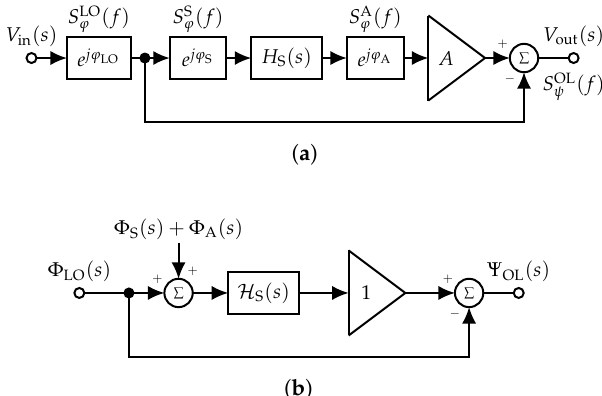
Figure 3. Basic structure of an open-loop sensor readout system together with the random phase contributions of the individual components ( a ). The use of the phase-space equivalent system ( b ) simplifies phase noise analysis as phase noise turns into additive noise, but requires the determination of the phase-space equivalent transfer function of the sensor H S ( s ) . ( a ) Open-loop system with random phase contributions; ( b ) phase-space equivalent system.